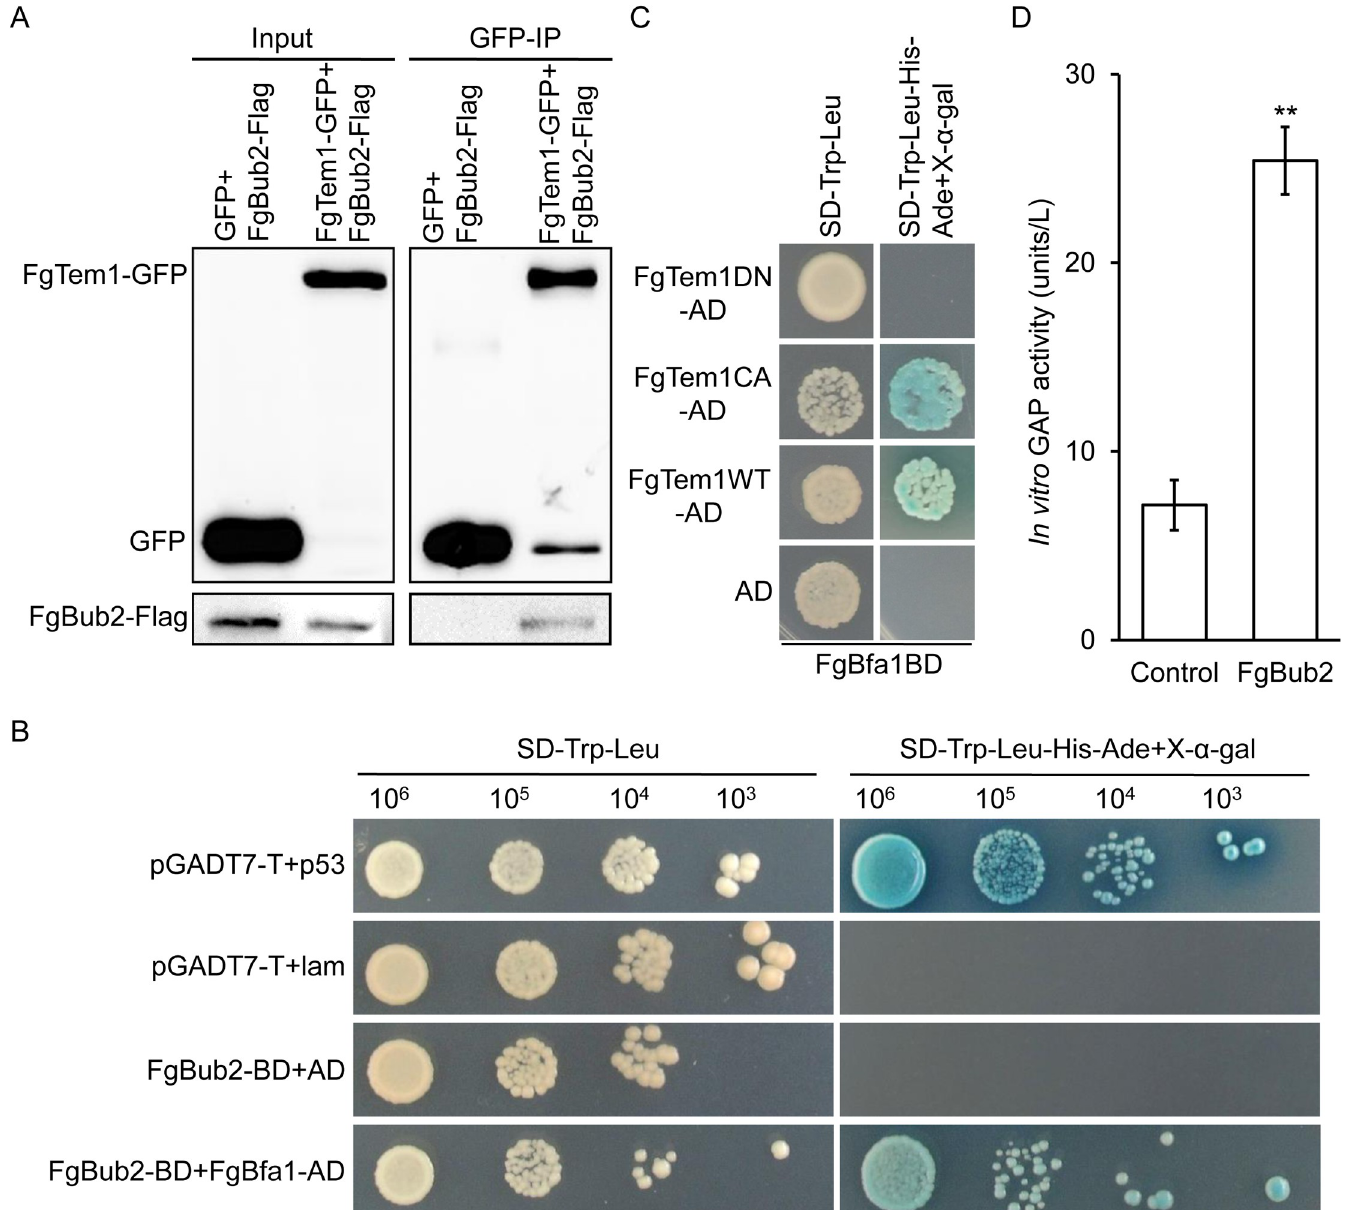
Fig 4. Interacting relationship of FgBub2 and FgBfa1 with FgTem1. (A) Co-IP assay showing positive interaction between FgBub2 and FgTem1. (B) Yeast two-hybrid assay showing positive interaction between FgBub2 and FgBfa1. (C) FgBfa1 directly interacts with FgTem1WT and FgTem1CA (Q163L) but not with FgTem1DN (T118N) in a yeast two-hybrid assay. (D) In vitro GAP activity assay of the His-FgBub2. Control: His. One unit is the amount of enzyme that catalyzes the production of 1 μ mol free phosphate per minute under the assay conditions. ( �� P <